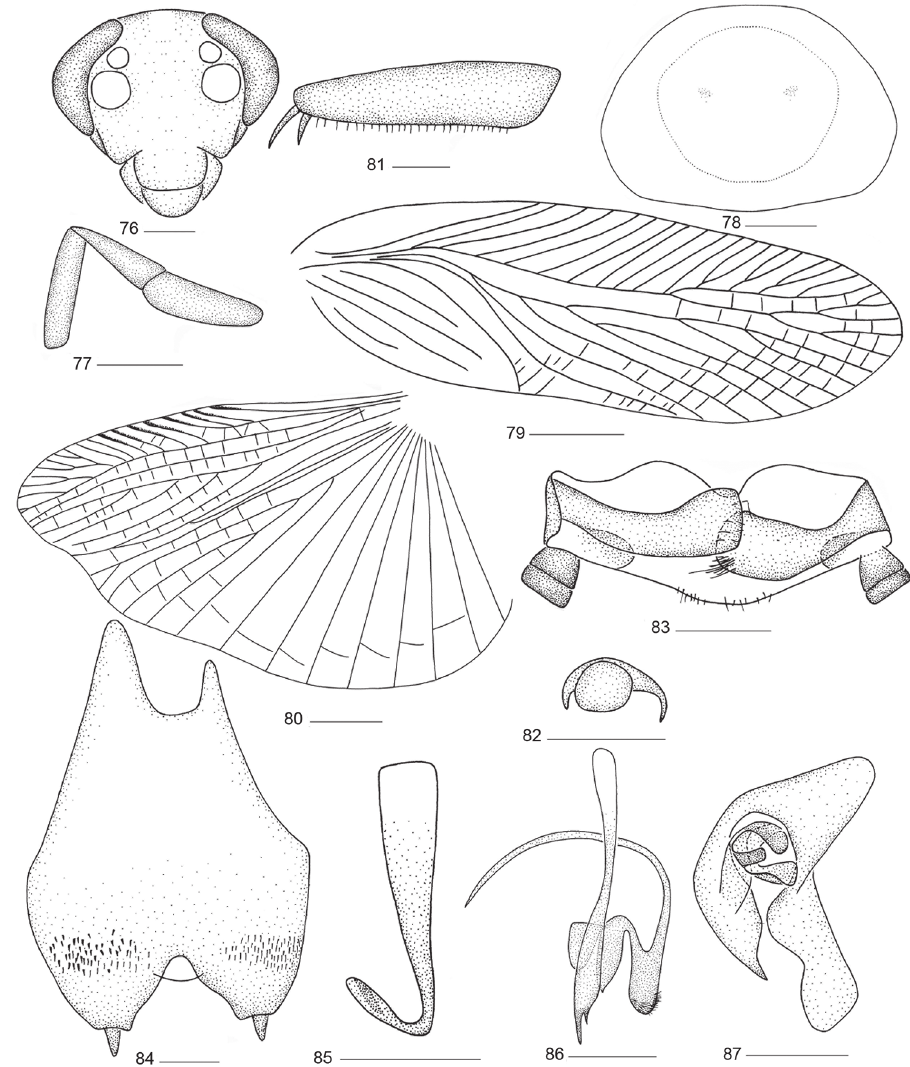
Figures 76–87. Balta nodigera (Bey-Bienko, 1958) comb. n. 76 head 77 maxillary palps 78 pronotum 79 tegmen 80 hind wing 81 front femur 82 tarsal claws and arolium 83 supra-anal plate and paraprocts, ventral view 84 subgenital plate, dorsal view 85 right phallomere 86 median phallomere 87 left phal- lomere. Scale bars: 0.5 mm ( 76–78, 81–87 ), 2.0 mm (Figs 79, 80 ). tarsal claws strongly asymmetrical and unspecialized (Fig. 82). Abdominal tergites unspecialized. Male genitalia. Supra-anal plate posterior margin slightly convex in the middle, paraprocts simple (Fig. 83). Subgenital plate in ventral view with hind margins